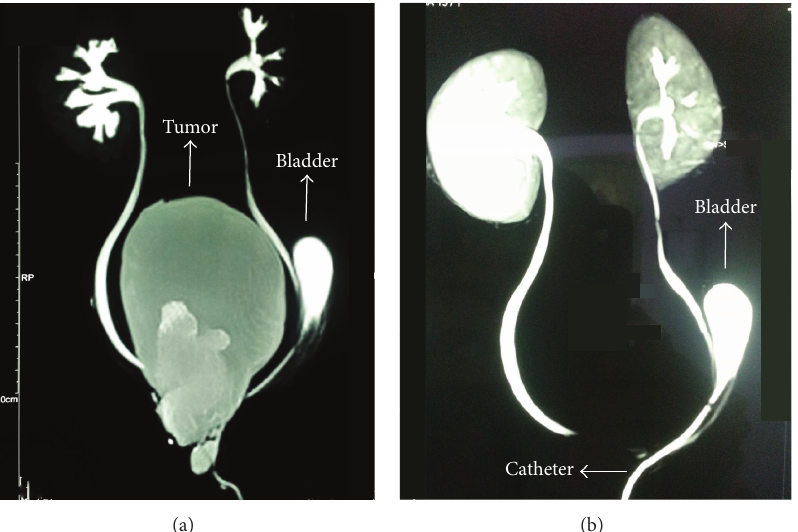
Figure 1: (a) Static magnetic resonance urogram showing the tumor displacing the bladder. (b) Functional magnetic resonance imaging showing ureters, displaced bladder, and hydronephrosis in both kidneys.